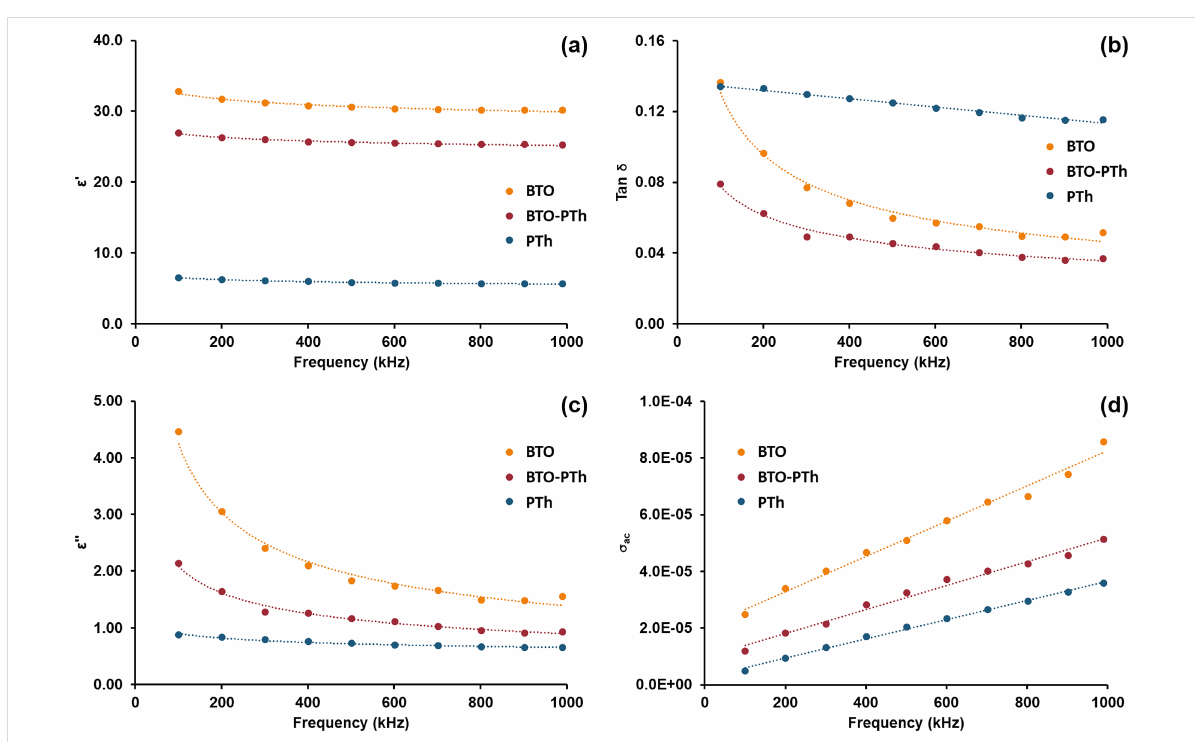
Figure 6: Dielectric properties of the as-prepared BTO nanoparticles, pristine PTh, and BTO-PTh nanoparticles. Permittivity or dielectric constant (a), loss tangent (b), dielectric loss (c), and ac conductivity (d) are plotted as a function of the